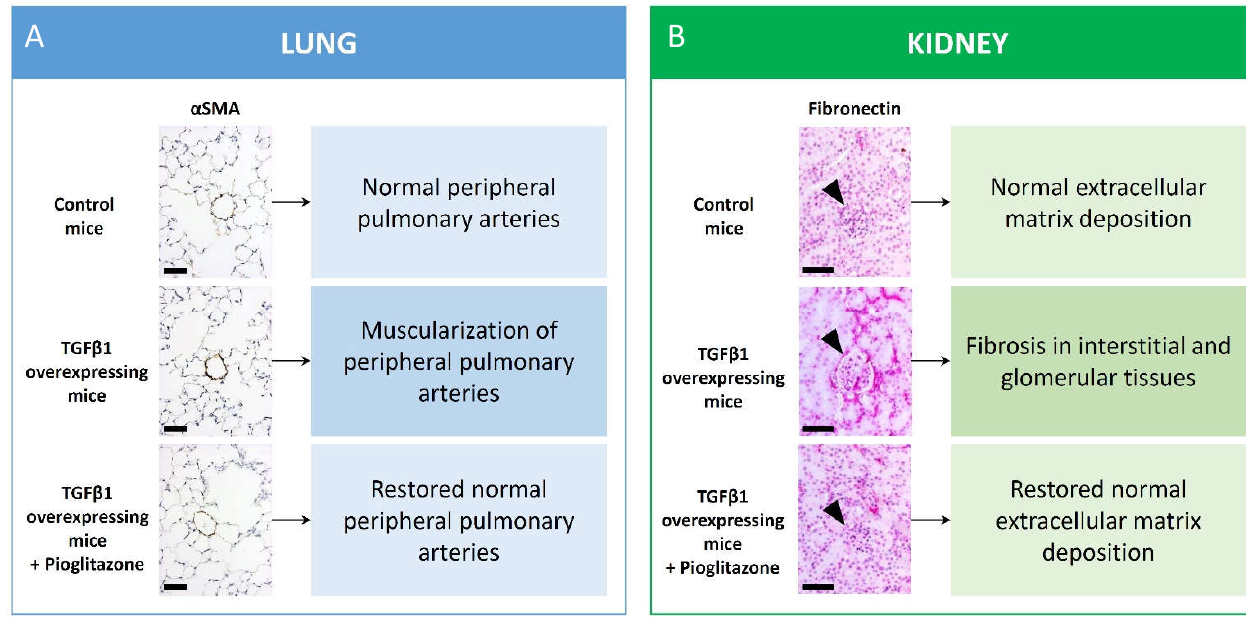
Figure 1. Representative photomicrographs of lung and kidney immunohistochemistry in TGFβ overexpressing mice treated with pioglitazone. Lungs stained for αSMA depicted significant muscularization of peripheral pulmonary arteries in untreated TGFβ overexpressing mice as compared to controls but restored arterial wall morphology upon pioglitazone treatment ( A ). Scale bar: 50 µm. Fibronectin staining of the kidneys in untreated TGFβ overexpressing mice depicts increased tubulointerstitial and glomerular production (arrowhead points on glomeruli) but restored fibronectin content after chronic pioglitazone treatment ( B ). Scale bar: 50 µm.